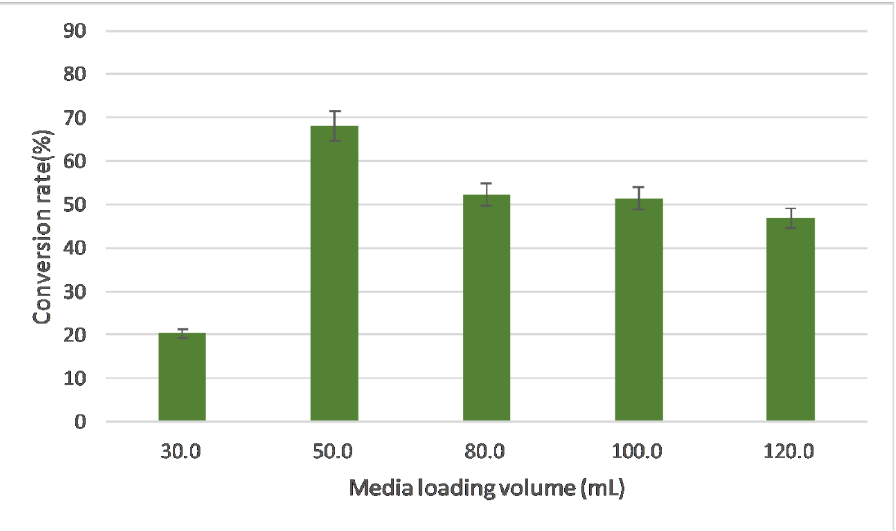
Figure 6. Effects of media volume on metabolite conversion rate (initial pH = 6.5, culture time 5 d, inoculation volume 10%, substrate concentration 1 mg/mL).